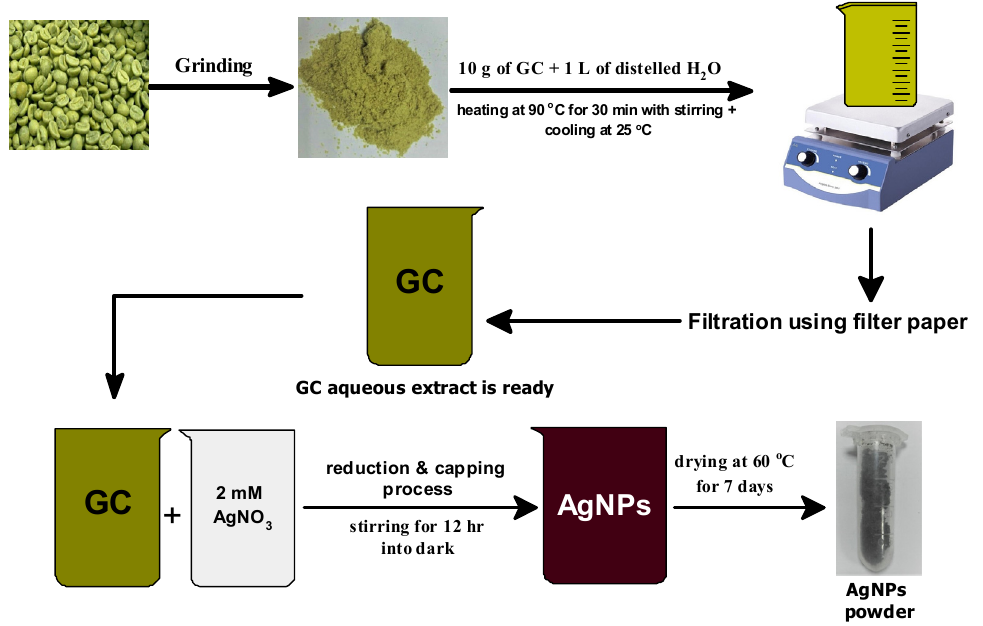
Figure 1. Schematic diagram of the preparation method of phyto-capped Ag NPs.